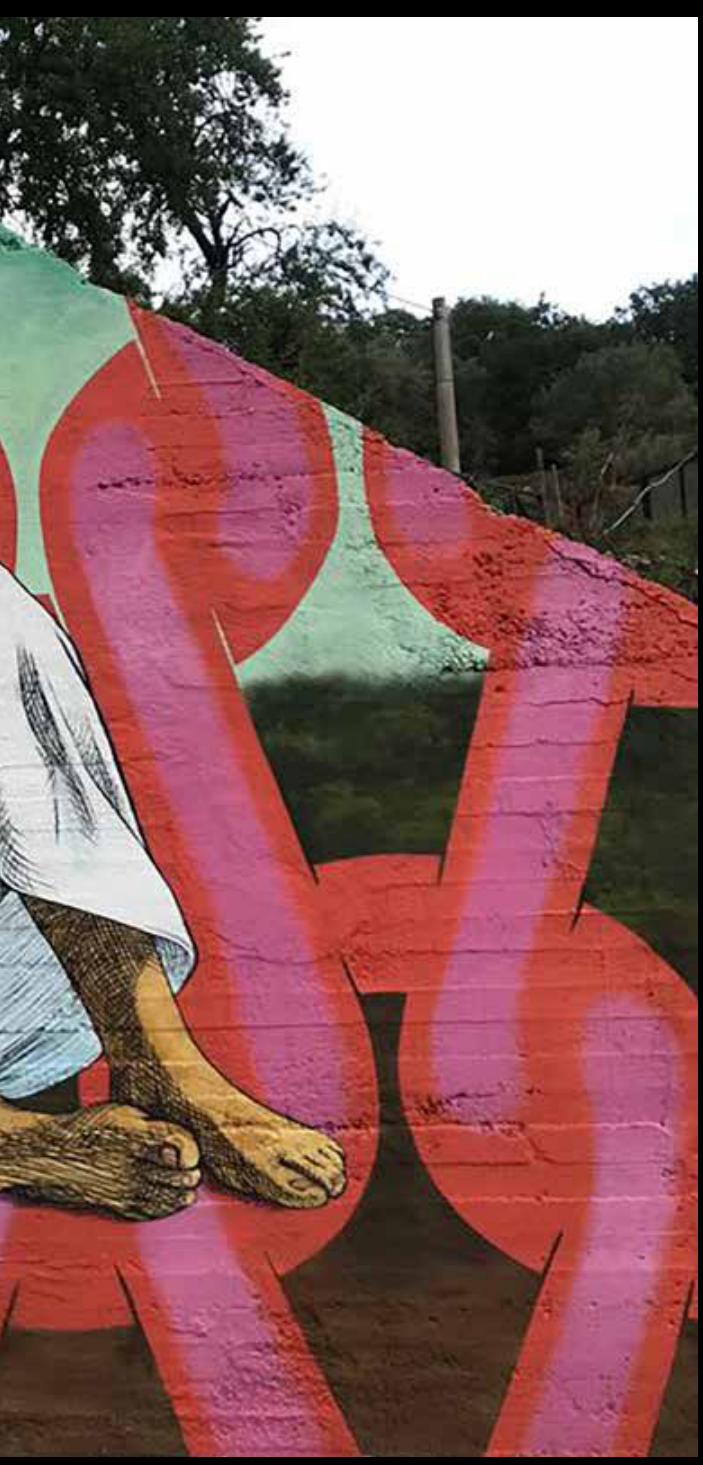
Figure 7: Jenny Roesel Ustick, Reconstruction I (detail), 2018. Acrylic on mixed masonry wall. Part of the Graniti Murales Residency with Art Project Graniti. Graniti Sicily, Messina, Italy. The background contains a stretched version of the Winslow Homer painting The Brush Harrow from the Reconstruction period following the American Civil War. The background is overlaid by a network of knitted stitches that were developed as a motif in